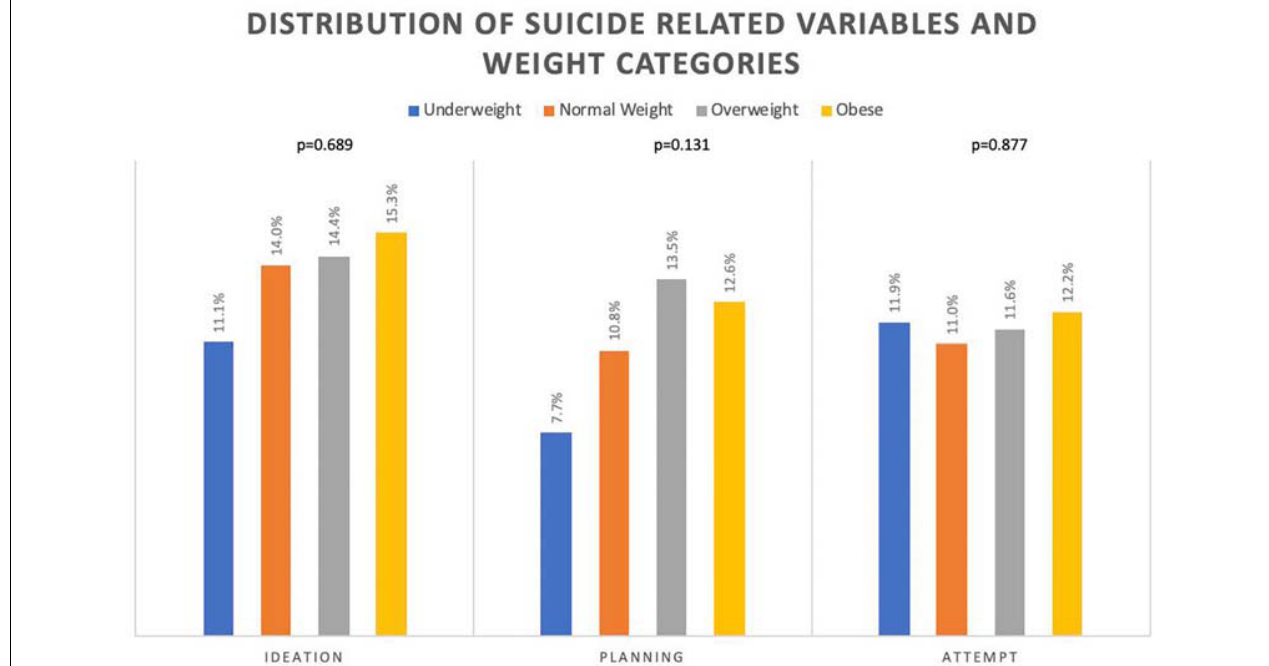
FIGURE 1 | The distribution of suicide ideation, planning, and attempts among weight categories.